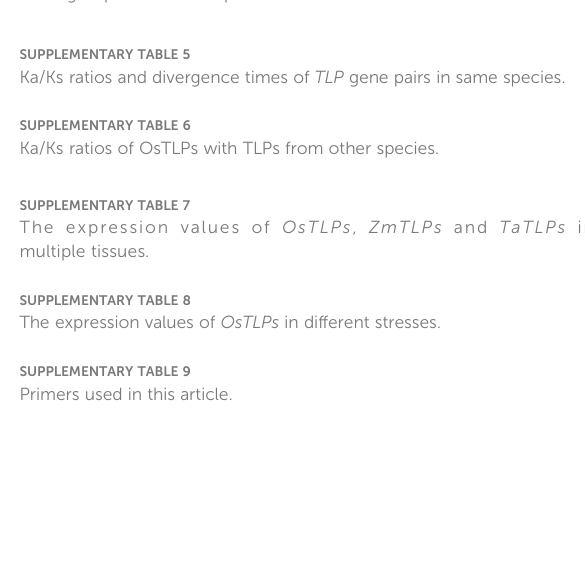
SUPPLEMENTARY TABLE 4 Orthogroups in seven crops.